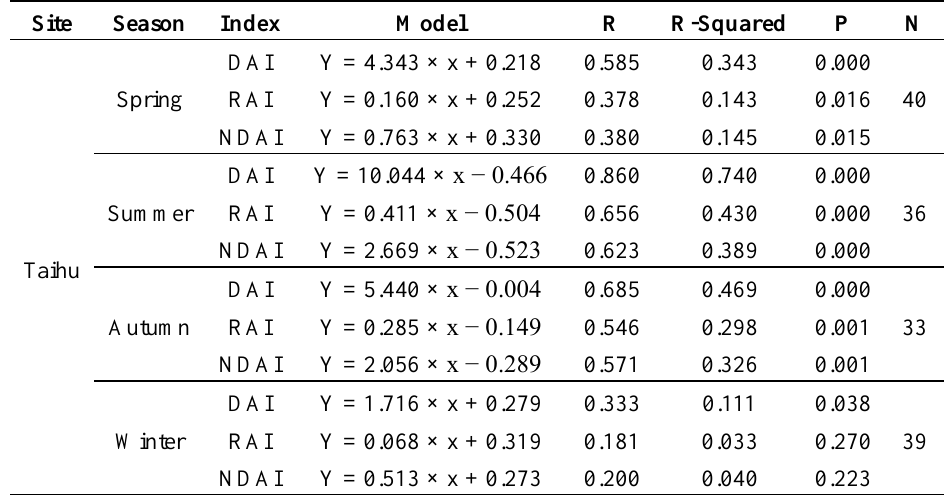
Table 4. Correlation coefficient between aerosol indices and in situ measured